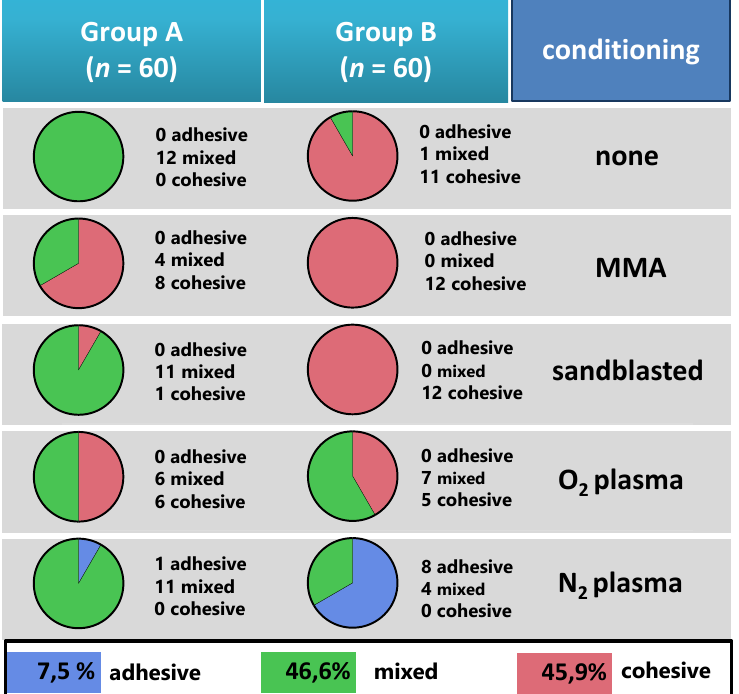
Figure 9. Fracture modes encountered after the shear bond testing. Pie charts with total numbers of adhesive (top), mixed (middle), and cohesive (below) fracture modes in the two experimental groups (Groups A and B) and five subgroups (surface conditioning).